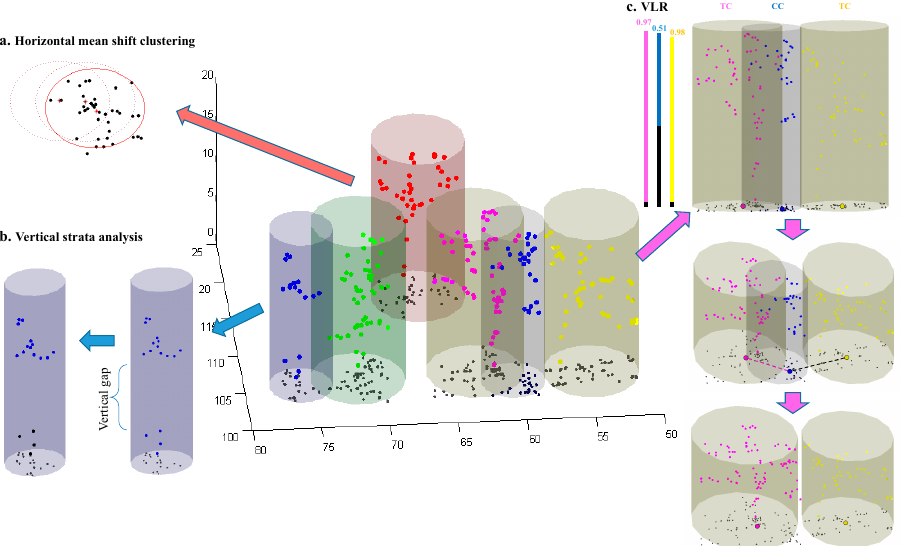
Figure 4. Visualization of the stepwise tree detection approach, including horizontal mean shift clustering (HMeanShift), vertical strata analysis, and the vertical length ratio (VLR). The black dots in the main graph represent the horizontal projections of LiDAR points, and the different colors represent the clusters created by HMeanShift. The HMeanShift graph ( a ) shows the search radius (red circles), the final position of the cluster (solid-lined circles), and the pathway of the mean shift (dash-lined circles). In the vertical strata analysis graph ( b ), the blue dots within the left cylinder represent the original LiDAR points in the cluster, while the blue dots within the right cylinder represent the crown points without ground residuals (black dots). The VLR graph ( c ) shows the VLR values of each cluster, with the blue cluster marked as a crown cluster and merged with the distance-closer pink